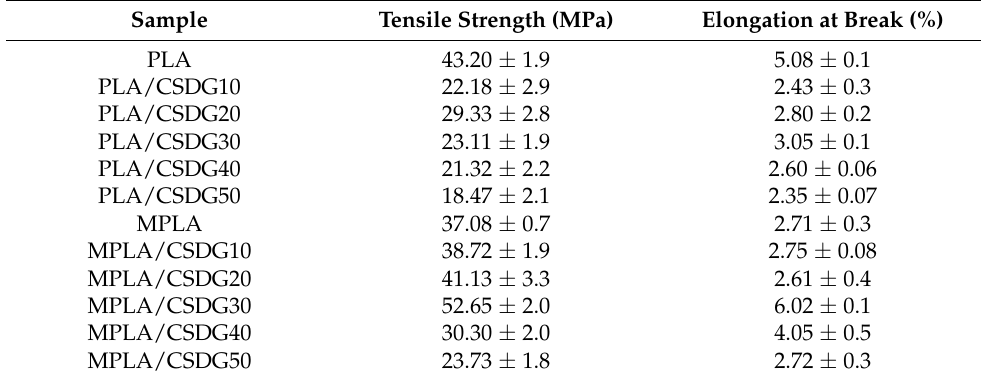
Table 2. Data on mechanical properties of PLA, PLA/CSDG, MPLA, and